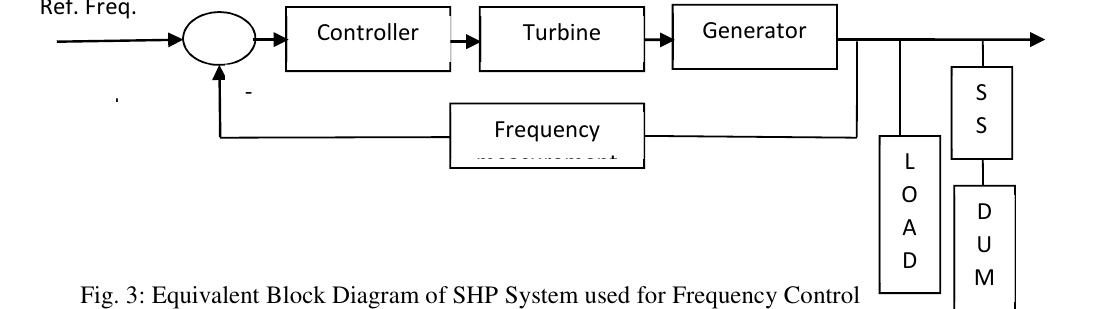
Fig. 3: Equivalent Block Diagram of SHP System used for Frequency